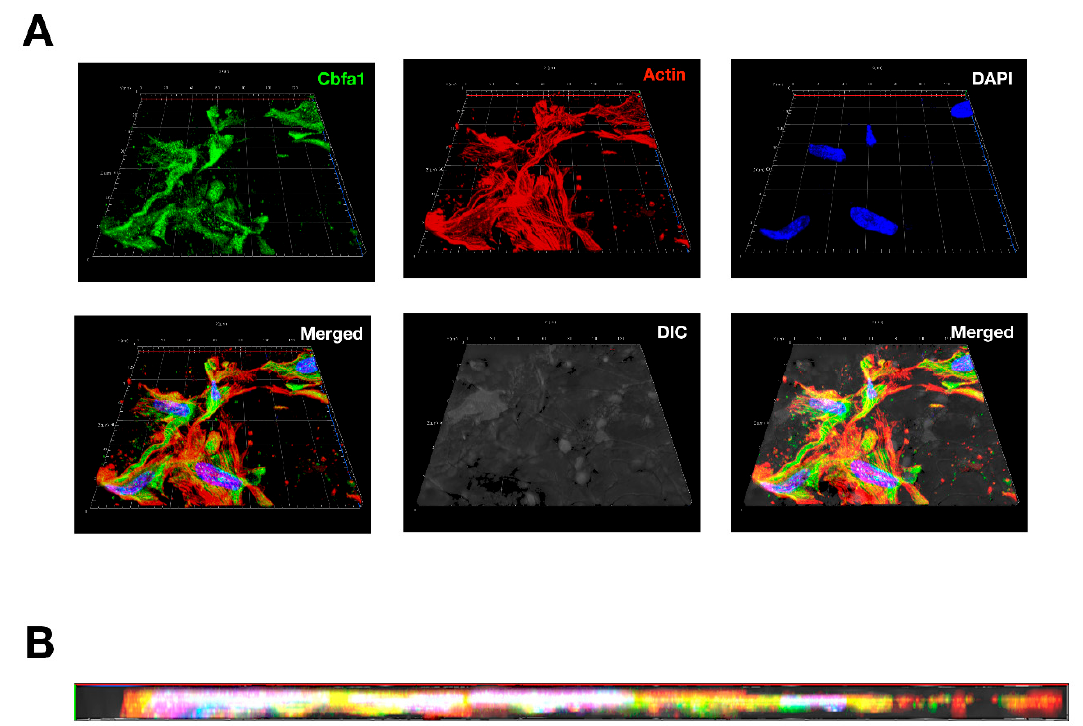
Figure 9. Confocal imagines of osteoblasts cultured on PAN nonwoven mats: ( A ) Top view of 3D confocal image of osteoblast seeding into specimen. The 130 × 130 mm confocal image were constructed from 10 consecutive 10 mm-thick sections. ( B ) Cross-section view of the constructed image as shown in ( A ). DAPI (blue), Cbfa1 (green), and actin (red) represent the staining method for labelling the nucleus, osteoblast-specific Cbfa1, and cytoskeleton of osteoblasts, respectively.